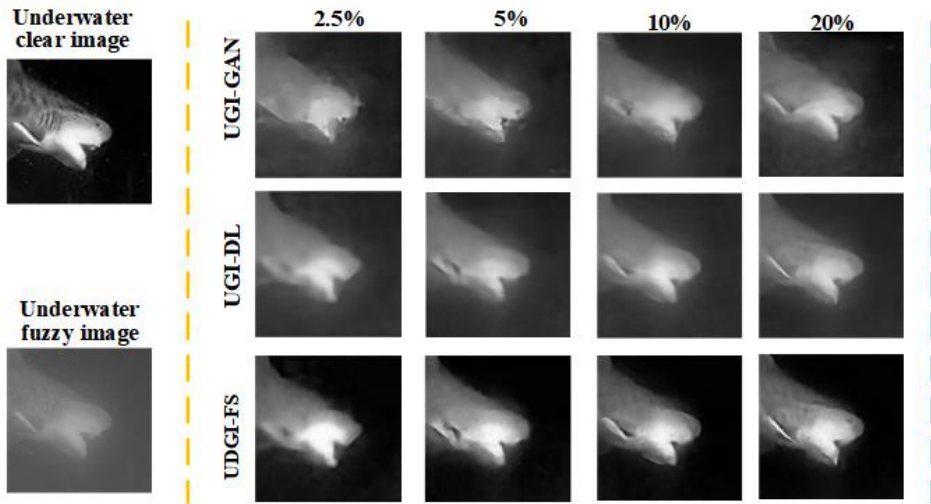
Figure 14. Comparison of reconstructed shark images of UDGI-FS, UGI-DL, and UGI-GAN at different sampling rates.